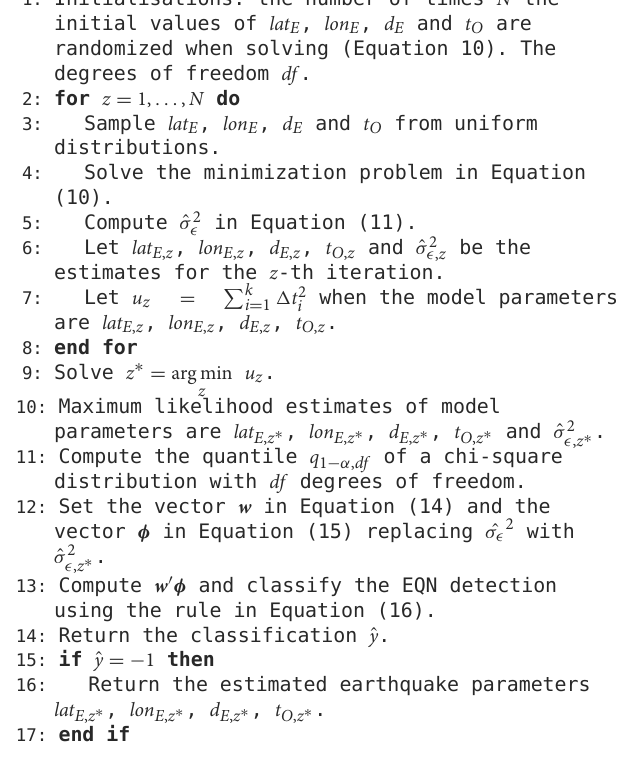
Algorithm 1. EQN detection classification and earthquake parameters estimation.